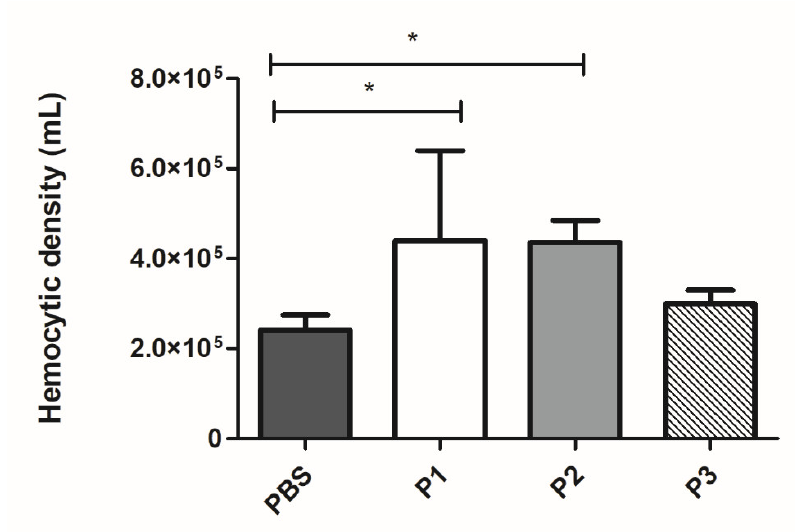
Figure 4. Effect of 14-3-3 peptides in hemocyte concentration of G. mellonella larvae. Data expressed as mean ± standard deviation of eight to 10 biological replicates and three independent experiments. * p < 0.05 using Kruskal–Wallis and Dunn’s test.